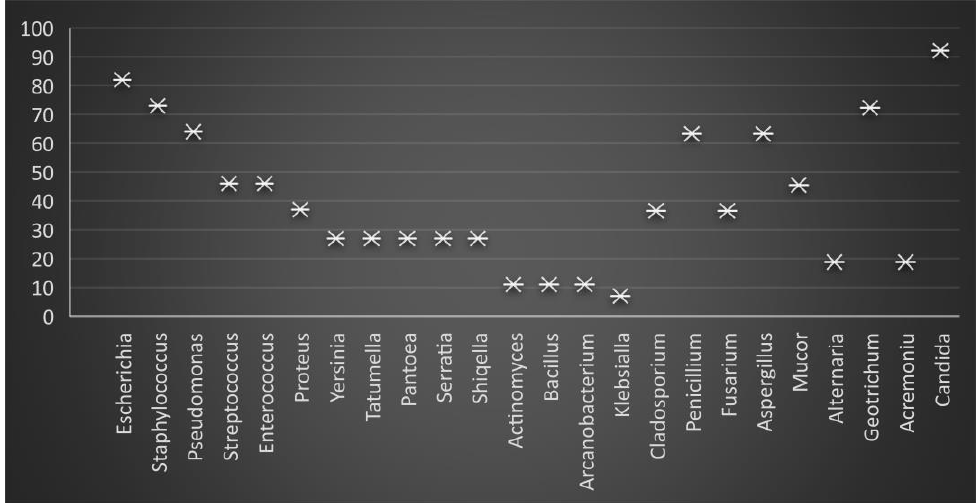
Figure 1. Graphic presentation of the percentage of microbiological load in freshly collected (raw) boar semen.